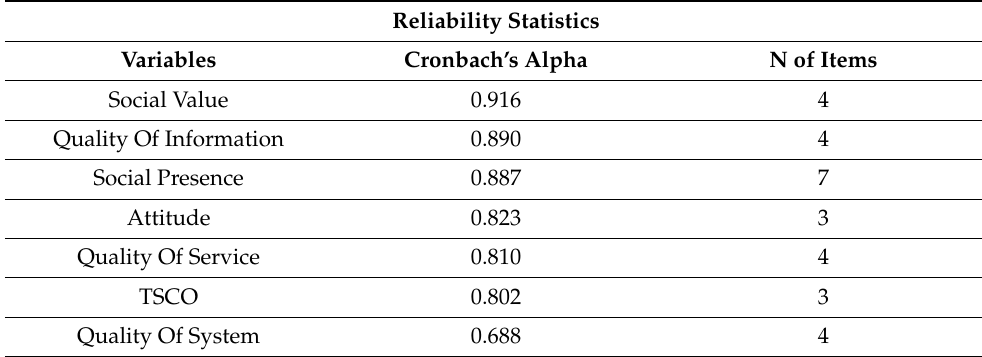
Table 2. The results of the reliability test (Cronbach